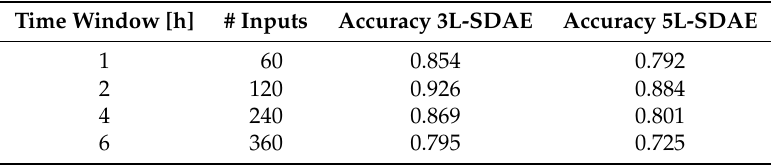
Table 2. Tested classification accuracy of the 3L-SDAE and 5L-SDAE architectures.